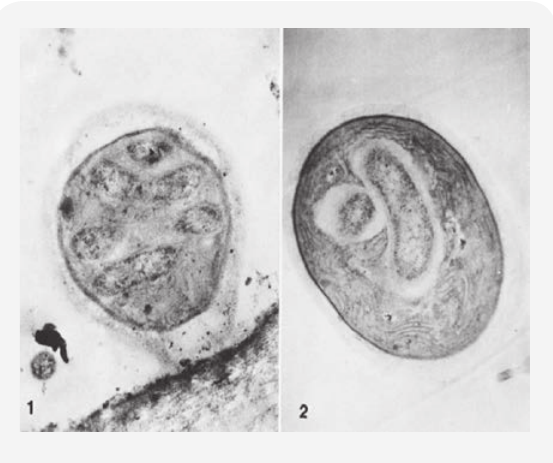
Figure 5. Bacterial cells in the cytoplasm of cyanobacteria, the only known example of intracellular bacteria within free-living bacteria. The endosymbiosis at the origin of eukaryotes might have looked a little similar to this. Courtesy of D.